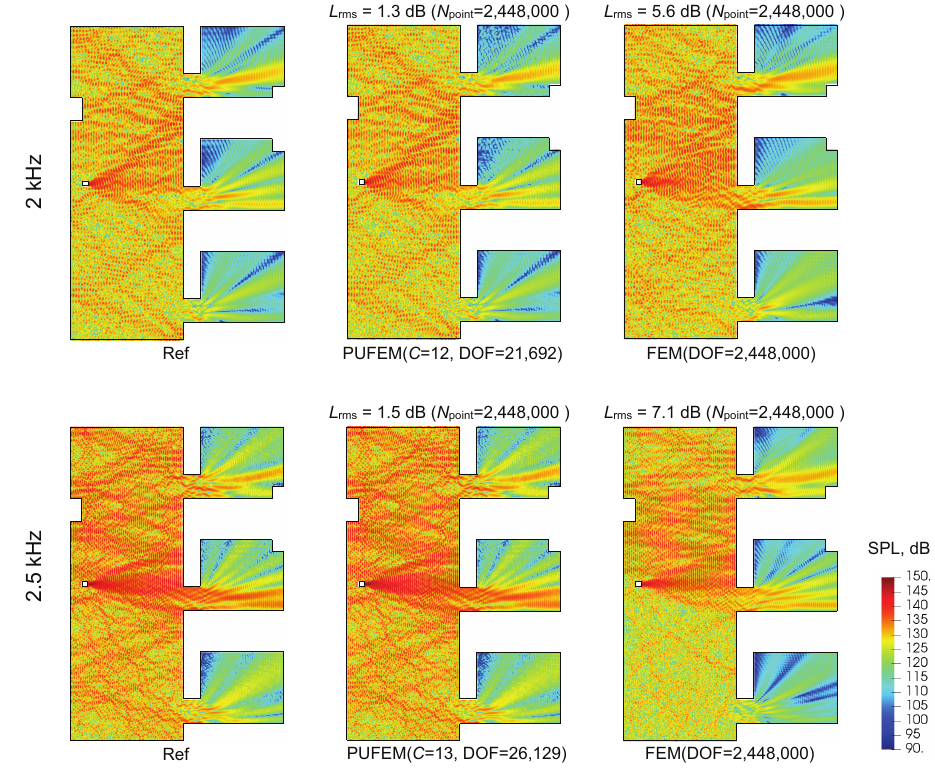
Figure 11. SPL distributions at 2 kHz ( upper ) and 2.5 kHz ( lower ) among Ref ( left ), PUFEM ( center ), and standard FEM ( right